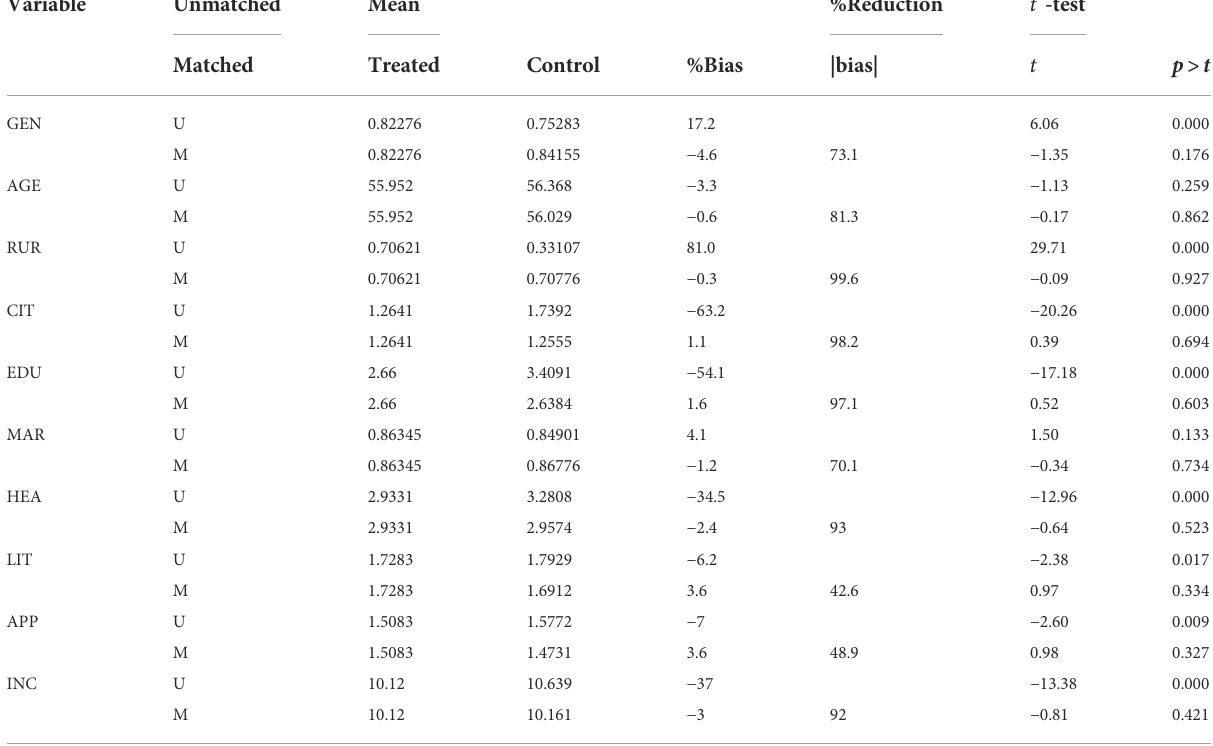
TABLE 4 Balance test results of propensity score matching (PSM).